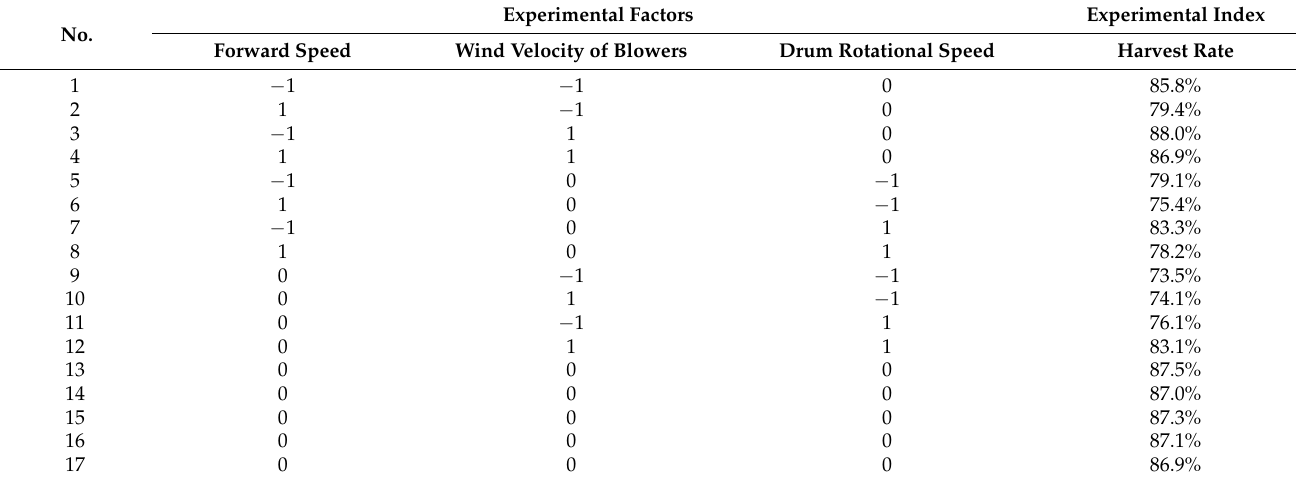
Table 4. Experiment scheme and results.